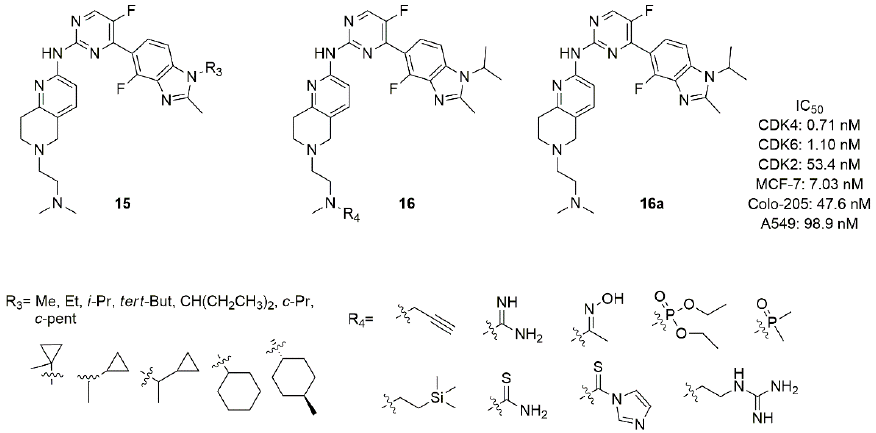
Figure 8. Structure of Shi’s research group of benzimidazolyl-pyrimidine derivatives.